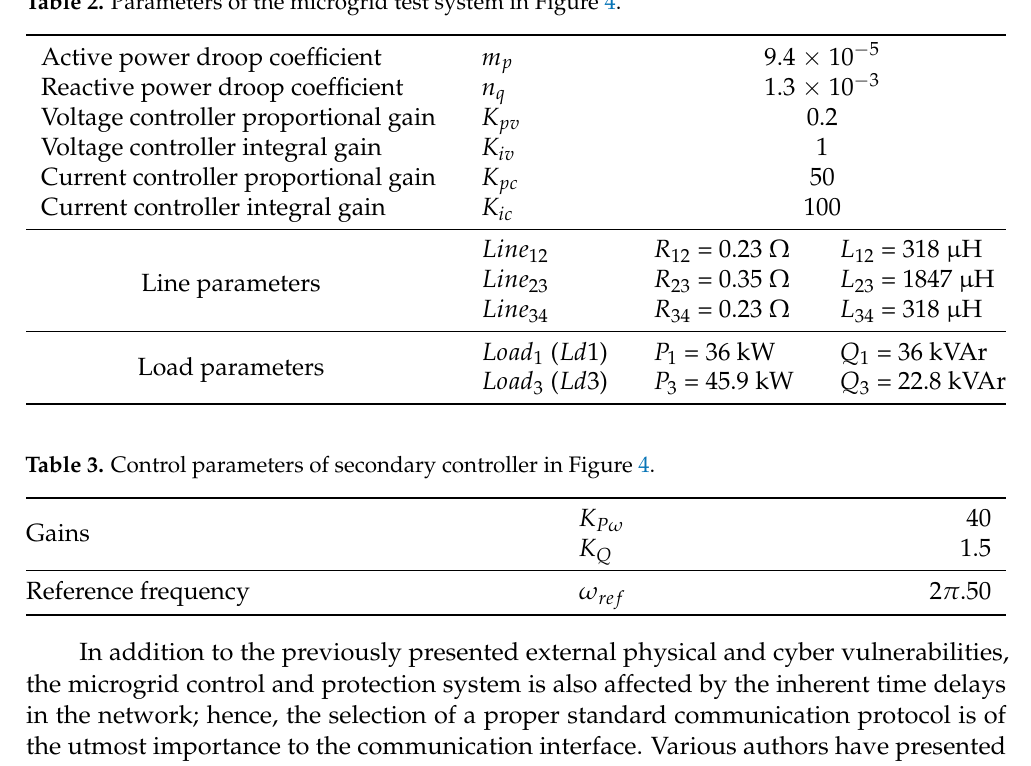
Figure 4. The control network of an islanded AC microgrid testbed. Table 2. Parameters of the microgrid test system in Figure 4.